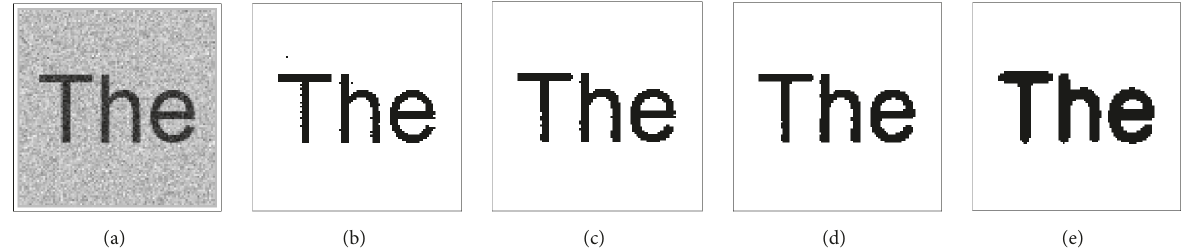
Figure 5: Figures depicting results obtained at increasing time using the current method and 𝛼 = 1 . (a) The original image, (b) binarized original image at 𝑡 ≈ 0 , (c) processed binary image at 𝑡 = 0.003 , (d) processed binary image at 𝑡 = 0.008 , (e) overdiffused image at 𝑡 = 0.01 .